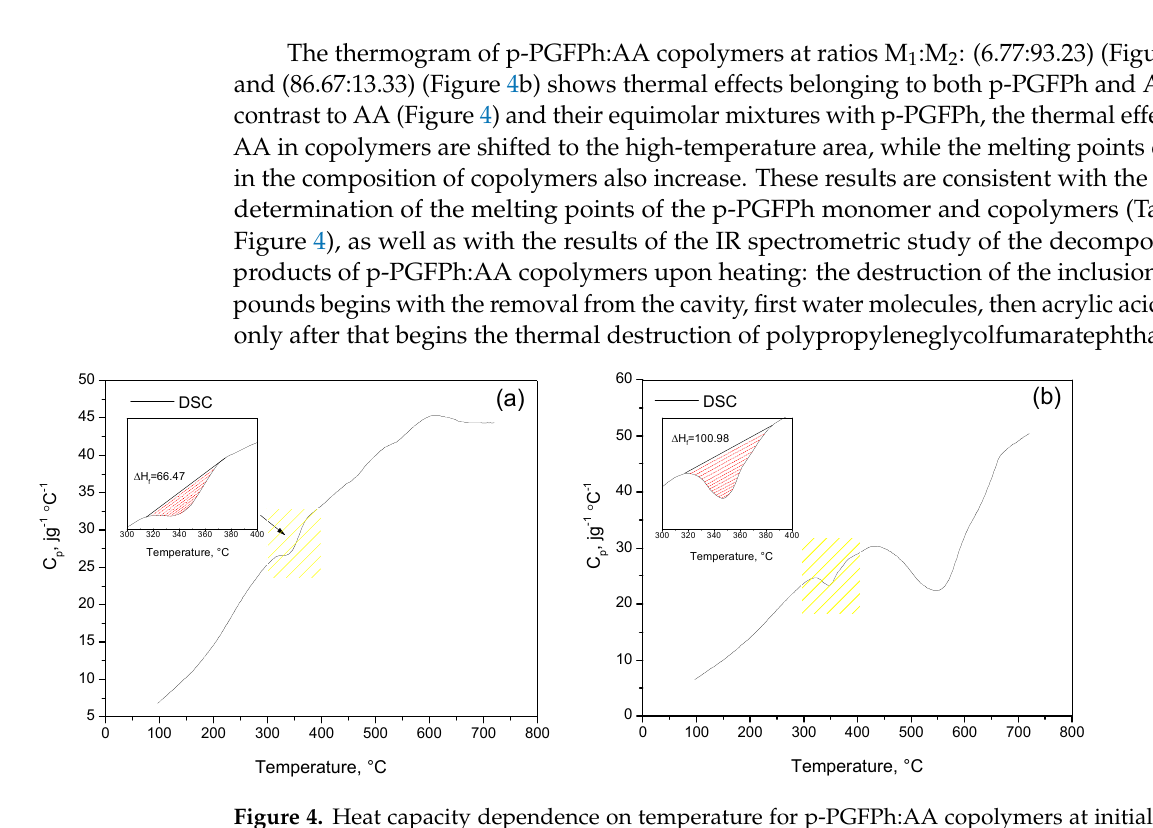
Figure 3. IR spectrums of p-PGFPh:АА decomposition products at ratios М 1 :М 2 , mol.%: ( a )−p- PGFPh; ( b )−6.77:93.23; ( c )−44.17:55.17 and ( d )−86.67:13.33 recorded at temperatures between 0 and 800 °С.